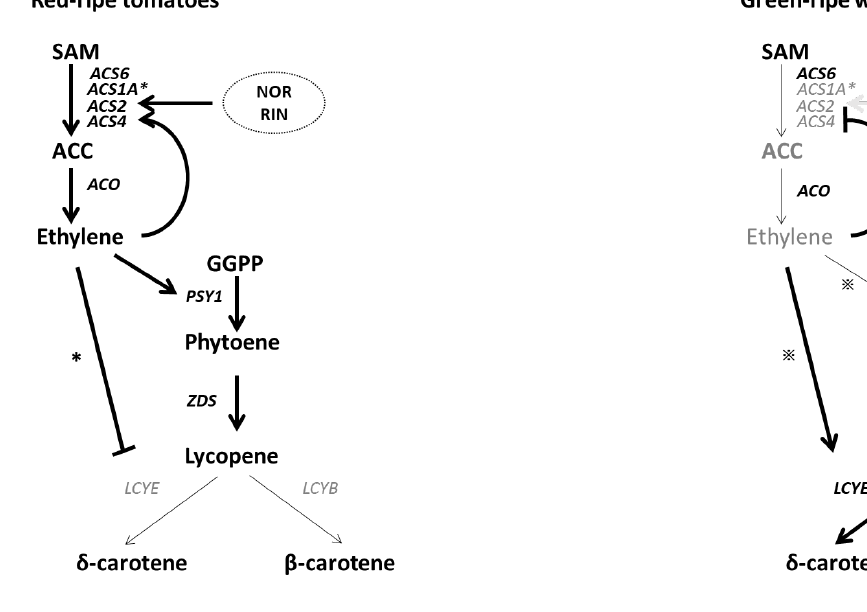
Figure 6. Current understanding of genetic control of ethylene biosynthesis and ethylene-mediated coloration in tomato. Bold lines and thin lines indicate the strength in corresponding activity. Characters in black indicate highly accumulated intermediates or enzymes, and characters in gray indicate relatively lowly accumulated intermediates or enzymes. * Significant response in S. lycopersicum cv. Ailsa Craig; ※ significant response in S. pennellii ; # significant response in S. peruvianum.